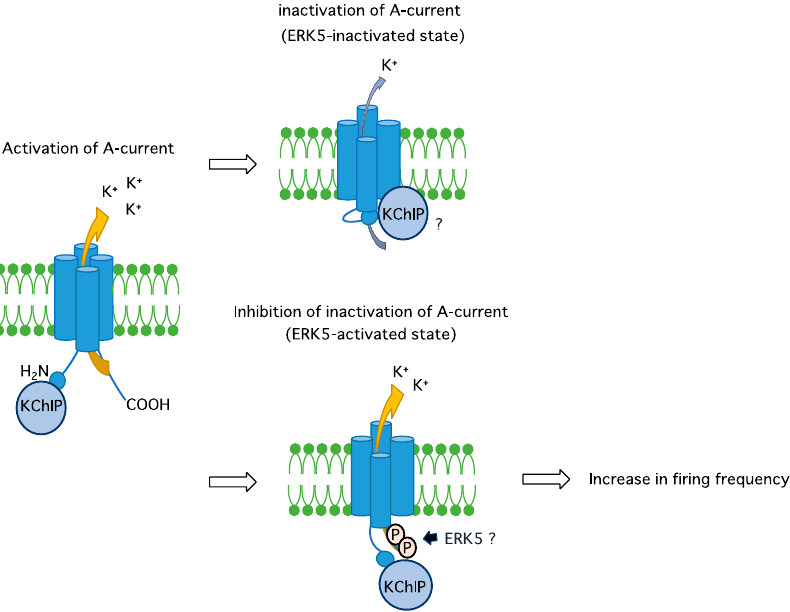
Figure 5. Putative mechanism of regulation of K v 4.2 channels by ERK5. The ERK5 phosphorylates unidentified Ser/Thr residue(s) on K v 4.2, resulting in the inhibition of the A-type current inactivation. This mechanism may contribute to rapid repolarization toward resting potential, which is necessary for causing the next